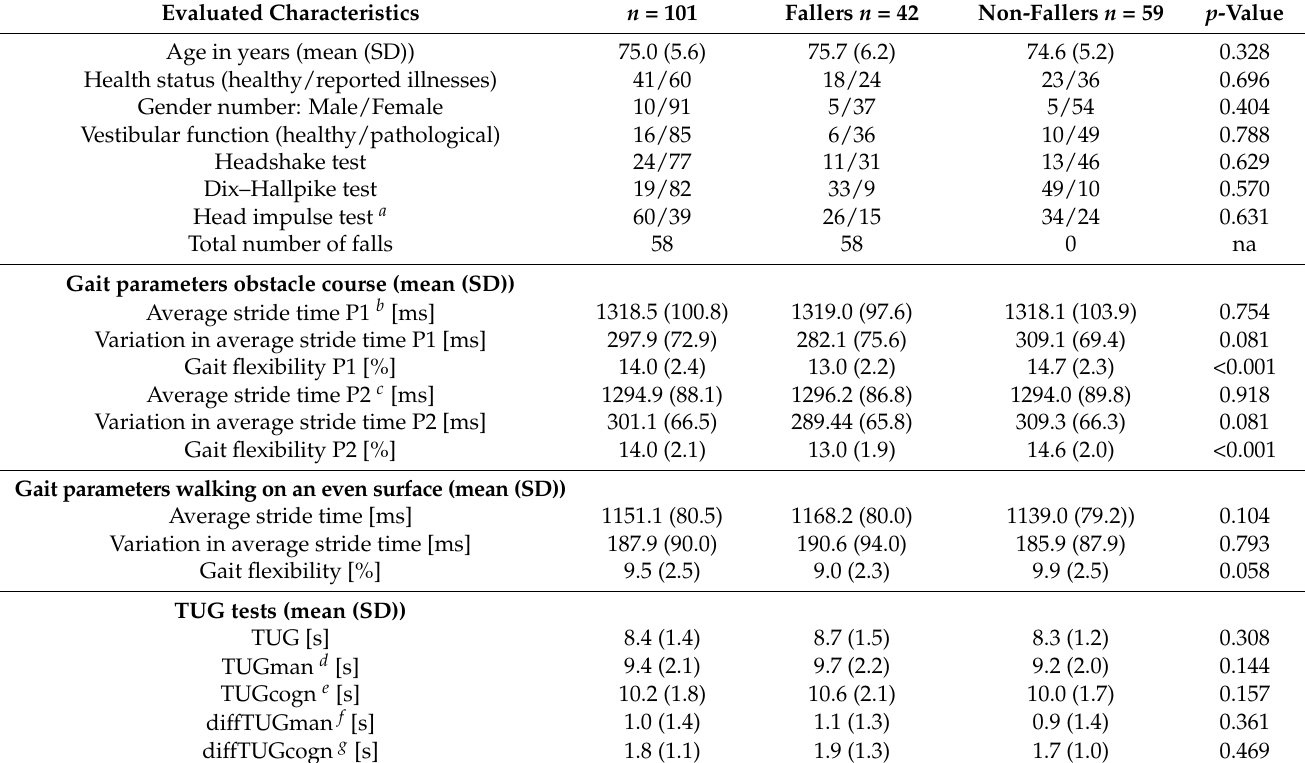
Table 1. Descriptive statistics of the participants, test results, and falls.